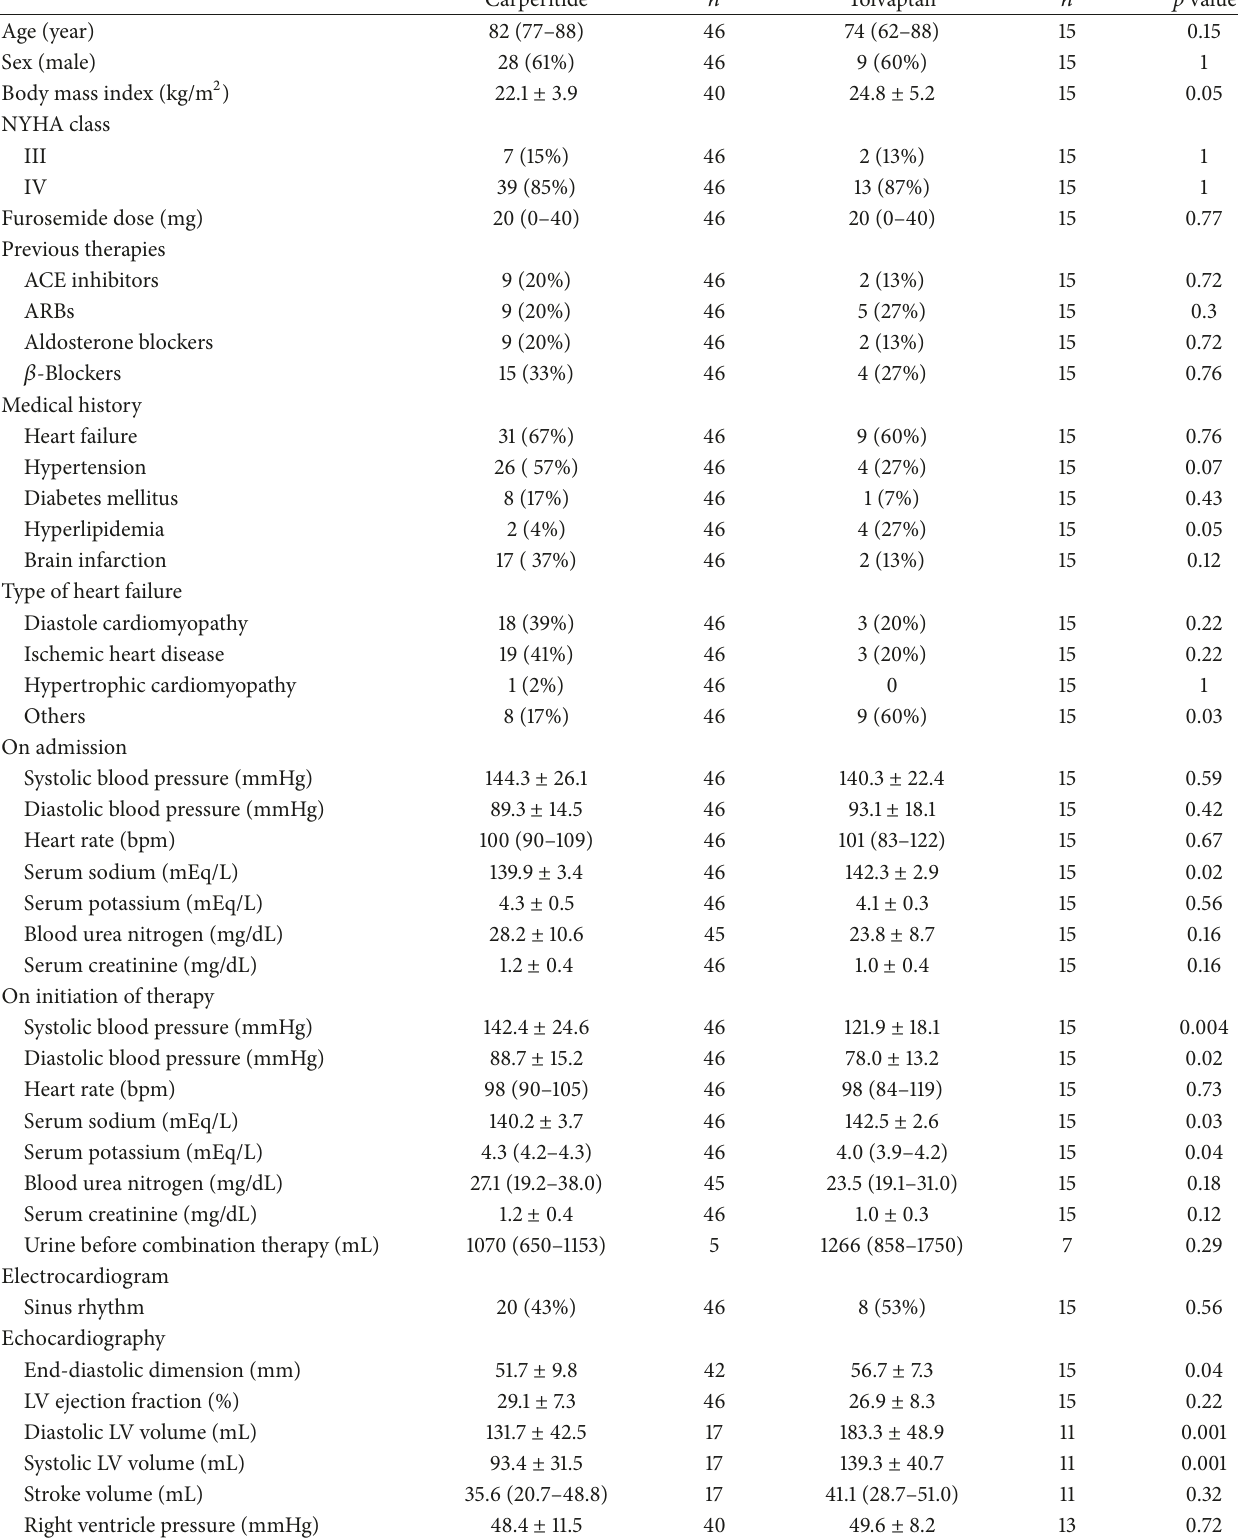
Table 1: Baseline characteristics. The values are expressed in mean (standard deviation) and median (interquartile range). NYHA =